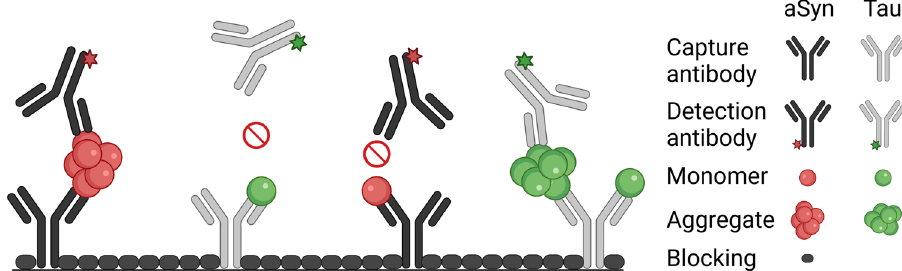
Fig. 1 Scheme of the sFIDA assay. Antibodies directed against linear epitopes of aSyn (211) or Tau (Tau5) are immobilized on the glass surface of a microtiter plate. Monomers and aggregates of the sample can bind to the capture antibodies, but only aggregates are detected with fl uorescently labeled probes (211 CF633 and Tau5 CF488A) because capture and detection antibodies bind the same epitope. For monomeric protein, this epitope is masked by the capture antibody and can therefore not be bound by a probe antibody. Finally, the assay surface is imaged by dual-color fl uorescence microscopy and single particles on the well surface are counted by image-data analysis. Created with BioRender.com .